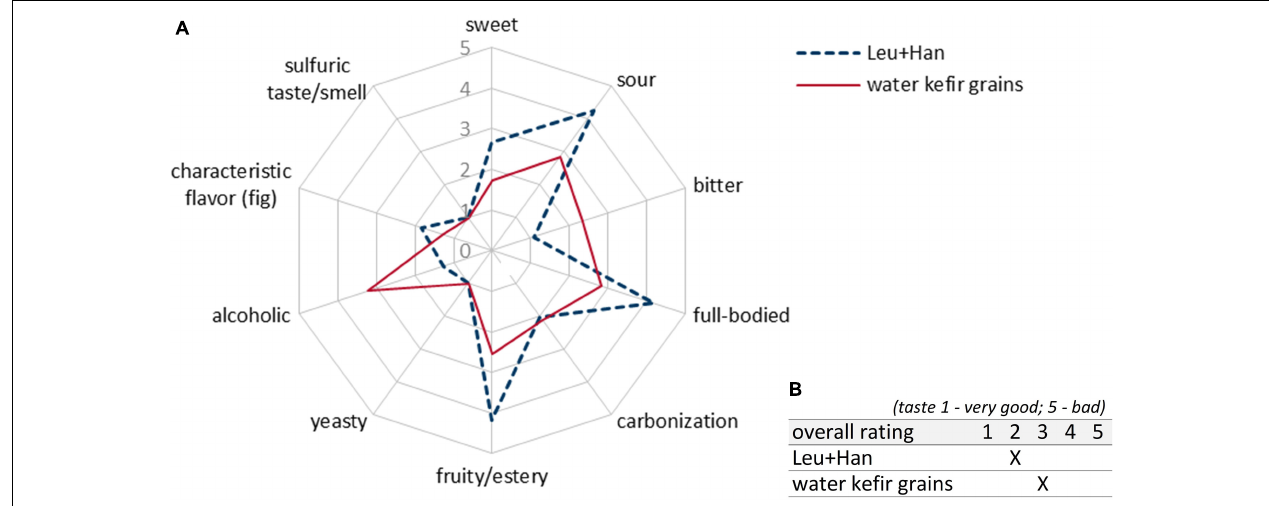
FIGURE 9 | Sensory properties (A) and rating (B) of products fermented with the combination of Leu + Han as well as WK grains in 5-L bioreactors. Shown are the mean data of biological triplicates at the best time of each single fermentation depending on the best achieved sensory properties: Leu + Han at 7 days of fermentations. Grain trial 1 (f1) at 3 days, trial 2 (f2) at 6 days, and trial 3 (f3) at 5 days of fermentation. The rating scale of the descriptive analysis (A) ranges from 1 (imperceptible) to 5 (very pronounced). The overall rating of the taste (B) ranges from 1 (very good) to 5 (bad taste). WK, water